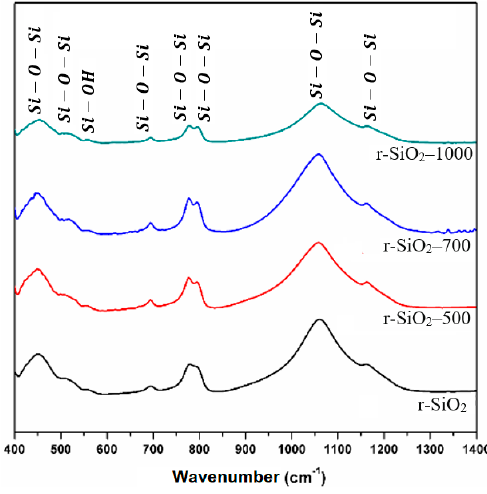
Figure 7. FTIR spectra of the SiO 2 aggregate without heat treatment and heated at 500 °C, 700 °C, and 1000 °C.